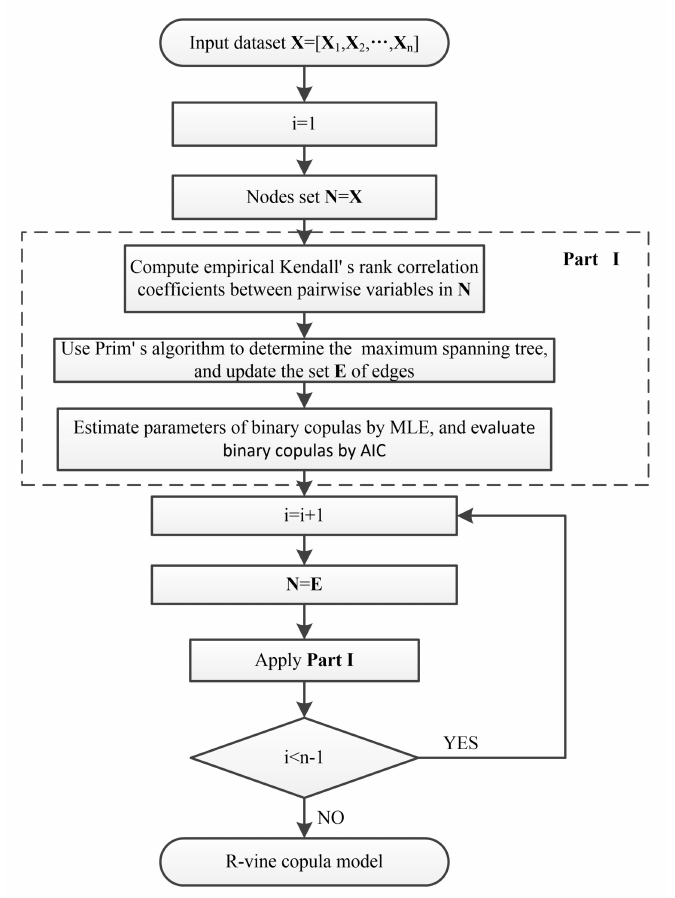
Figure 3. The flowchart depicting the formation of the R-vine copula